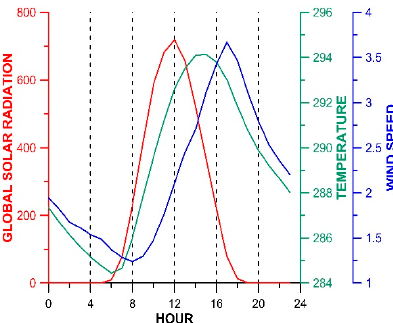
Figure 5. Average diurnal behavior of solar radiation (red line), temperature (green line), and wind speed (blue line) in an urban site (Xochimilco) of Mexico City during 2001 [11,25]. We observe that